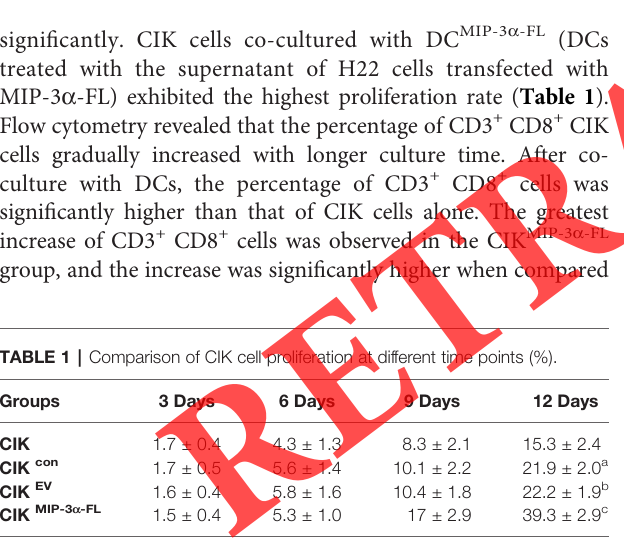
FIGURE 2 | H22 cells transfected with MIP-3 a -FL can promote DC maturation and enhance the chemotaxis of DCs. (A) DC formed dendritic shapes (optical microscope, magni fi cation ×100). (B) Flow cytometry results of DCs after different H22 supernatannt treatment. (C) Chemotactic effect of the MIP-3 a -FL gene-